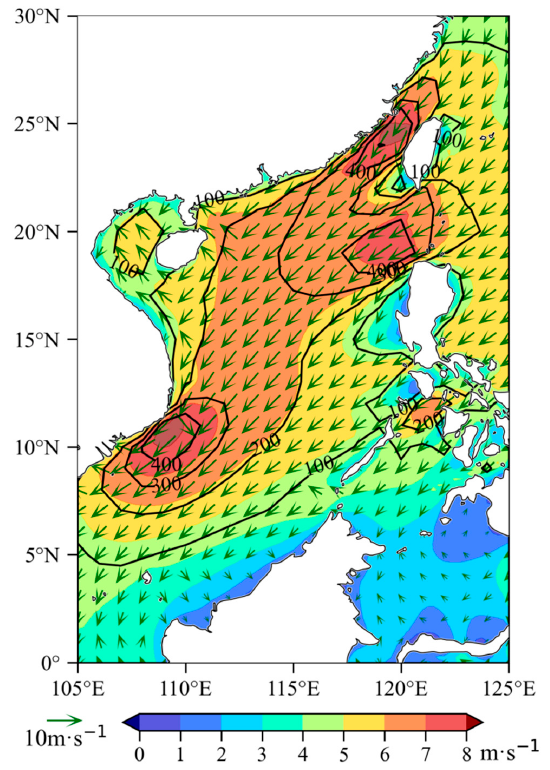
Figure 2. The annual mean distribution of wind (shaded, vector, and unit: m ‧ s − 1 ) and wind power density (contour, unit: W ‧ m − 2 ) over the SCS from 1979 to 2021.